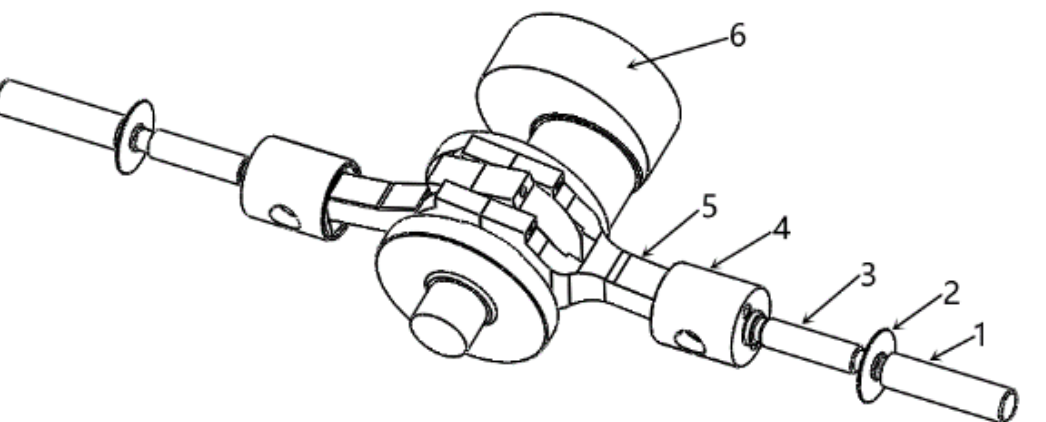
Figure 2. Opposed-power reciprocating pump in a separate column: 1. Plunger, 2. Manger, 3. Extension rod, 4. Crosshead, 5. Rod, 6. Crankshaft.